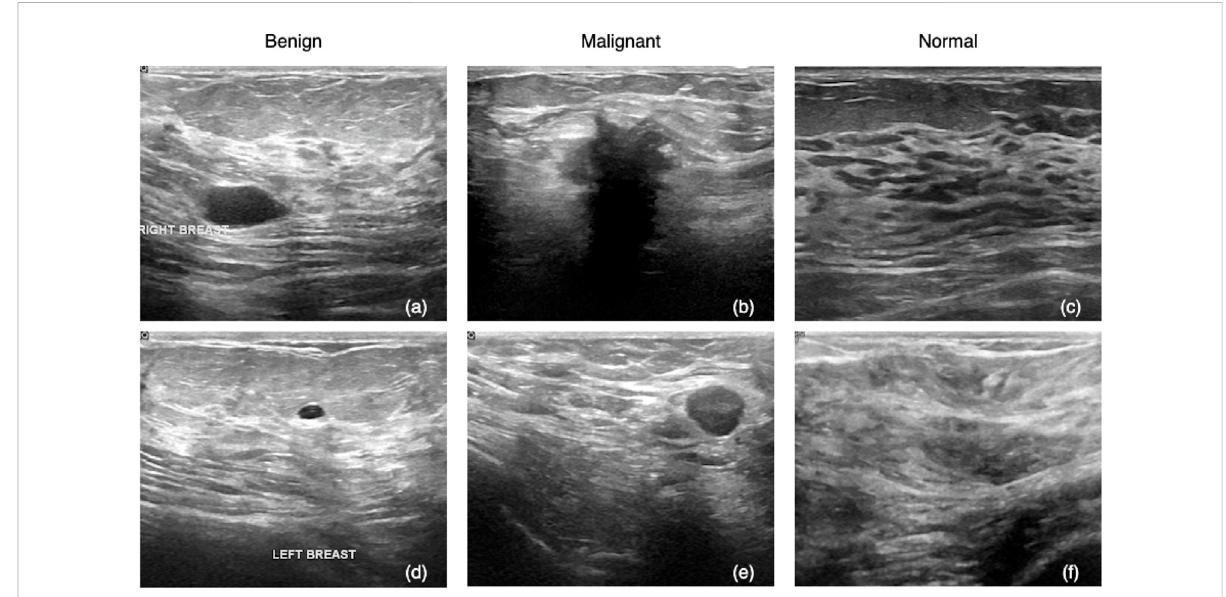
FIGURE 1 BUSI samples: (A,D) are benign tumor samples, (B,E) are malignant, and (C,F) are normal.